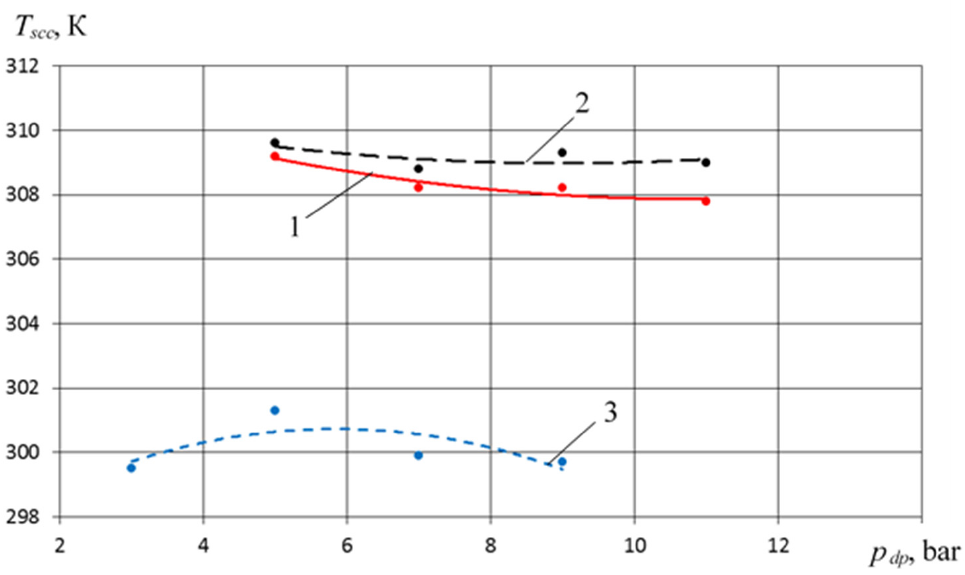
Figure 27. Dependence of the temperature of the suction gas on the discharge pressure of the pump section (1—PHPM with step-type gap seals; 2—PHPM with smooth gap seals; 3—Crosshead-free PHPM).